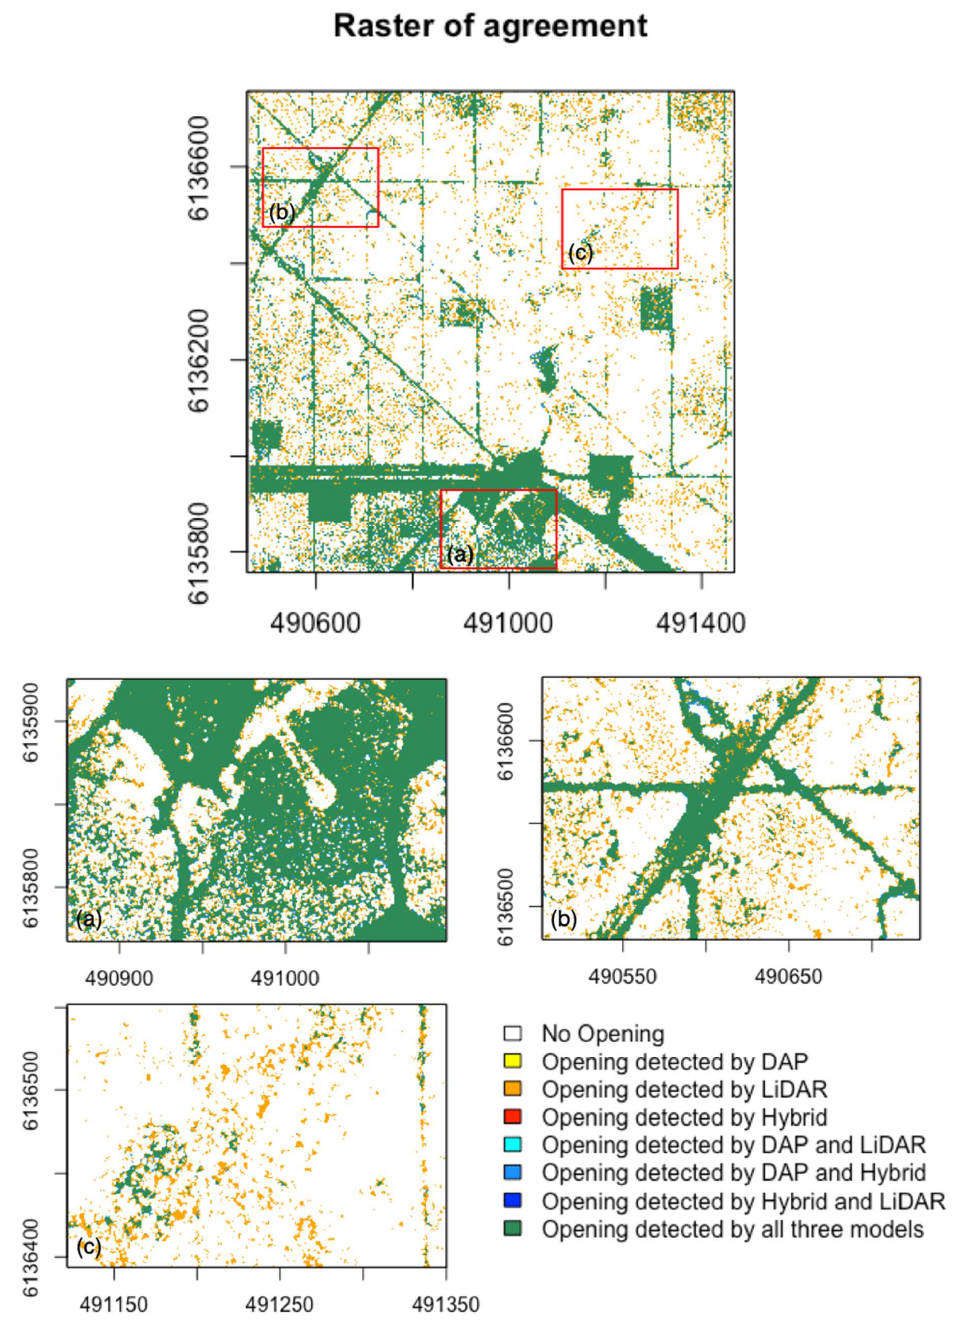
Figure 7. Raster of agreement for all three opening detection approaches, presented for the entire study area ( a ) and two excerpts, showing detailed distributions of agreement ( b ) and ( c ). The legend shows the number and kind of opening maps agreeing on the classification of a pixel as opening. Pixels with the value “0” are not classified as opening by any approach.